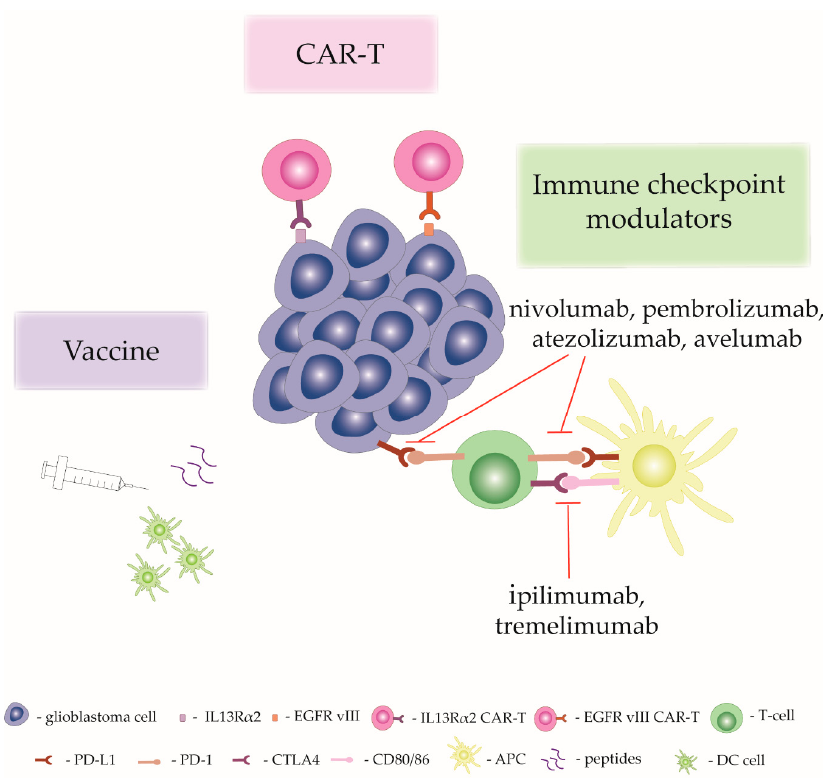
Note: CAR-T = immune checkpoint modulators and vaccine; CAR = chimeric antigen receptor; EGFR vIII = epidermal growth factor receptor vIII; IL13R α 2 = interleukin-13 receptor alpha-2; CTLA4 = T-lymphocyte-associated antigen 4; APC = antigen presenting cell; DC = dendritic cell; PD-1 = programmed cell death protein 1; PD-L1 = programmed cell death 1 ligand.